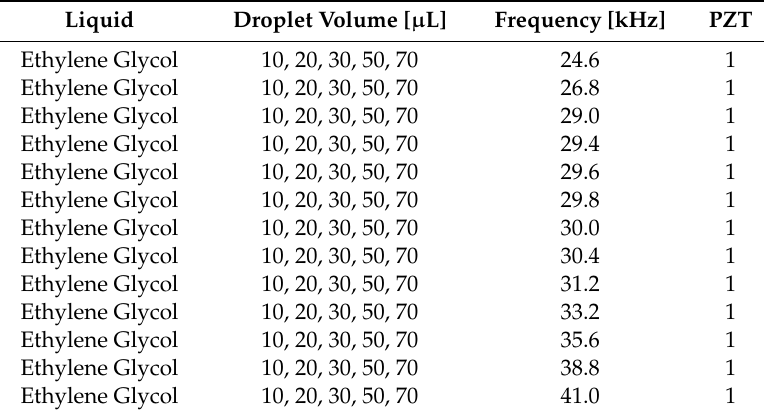
Table A3. Testing parameters used for the experiments conducted with ethylene glycol to investigate material property e ff